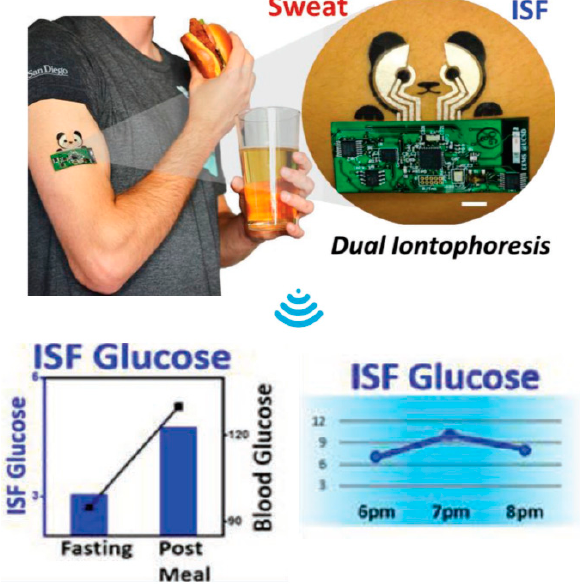
Figure 6. Depiction of a wearable iontophoretic biosensor device on a printed tattoo platform for glucose sensing on a human subject, along with wireless real-time transmission of the interstitial fluid (ISF) glucose [58] (reproduced with permission).